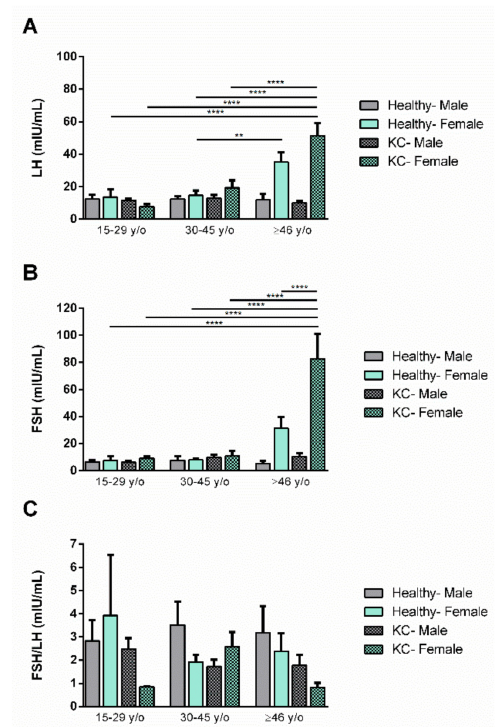
Figure 4. Age e ff ect as a function of gender expression of LH and FSH, and the LH / FSH ratio, in healthy and KC blood (plasma) samples. The following groups were investigated: Healthy Males 15–29 y / o (n = 7), Healthy Females 15–29 y / o (n = 4), KC Males 15–29 y / o (n = 18), KC Females 15–29 y / o (n = 2), Healthy Males 30–45 y / o (n = 10), Healthy Females 30–45 y / o (n = 12), KC Males 30–45 y / o (n = 26), KC Females 30–45 y / o (n = 12), Healthy Males ≥ 46 y / o (n = 5), Healthy Females ≥ 46 y / o (n = 9), KC males ≥ 46 y / o (n = 19), KC Females ≥ 46 y / o (n = 9). ( A ) LH levels in healthy controls and KCs, ( B ) FSH levels in healthy controls and KCs, and ( C ) the LH / FSH ratio in healthy controls and KCs, per age group. ** p < 0.01, **** p < 0.0001. (See Supplementary Materials—Figure S4).